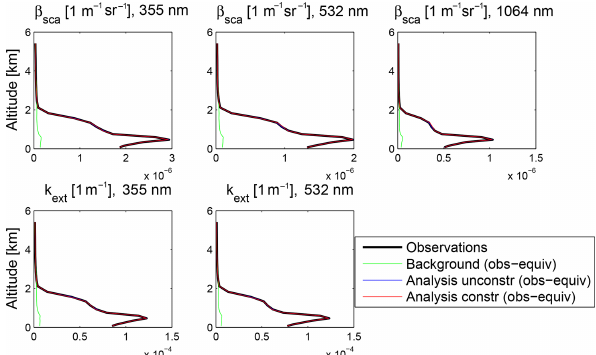
Figure 3. Observations (black solid line), and observation- equivalents of the background estimate (green), and of the uncon- strained (blue) and constrained (red) 3DVAR analysis. The optical parameters and wavelengths are indicated above each